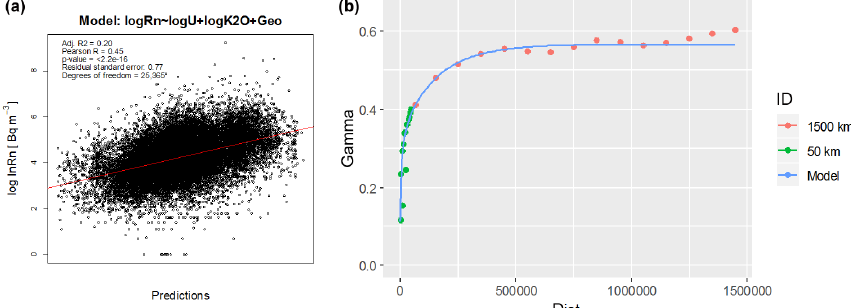
Figure 7. (a) Linear model and (b) variogram of